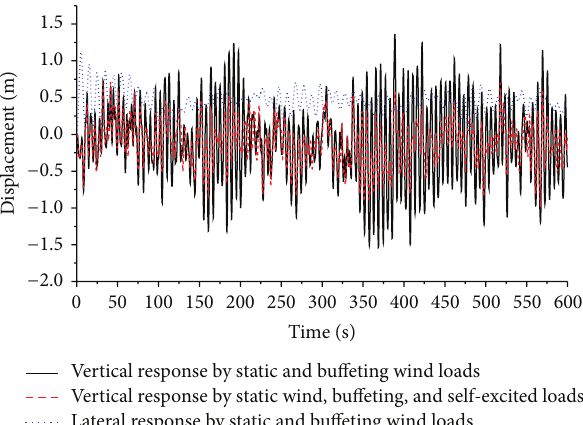
Figure 16: Time histories of dynamic responses produced by wind loads at point C ( 𝑈 = 49.8 m/s).